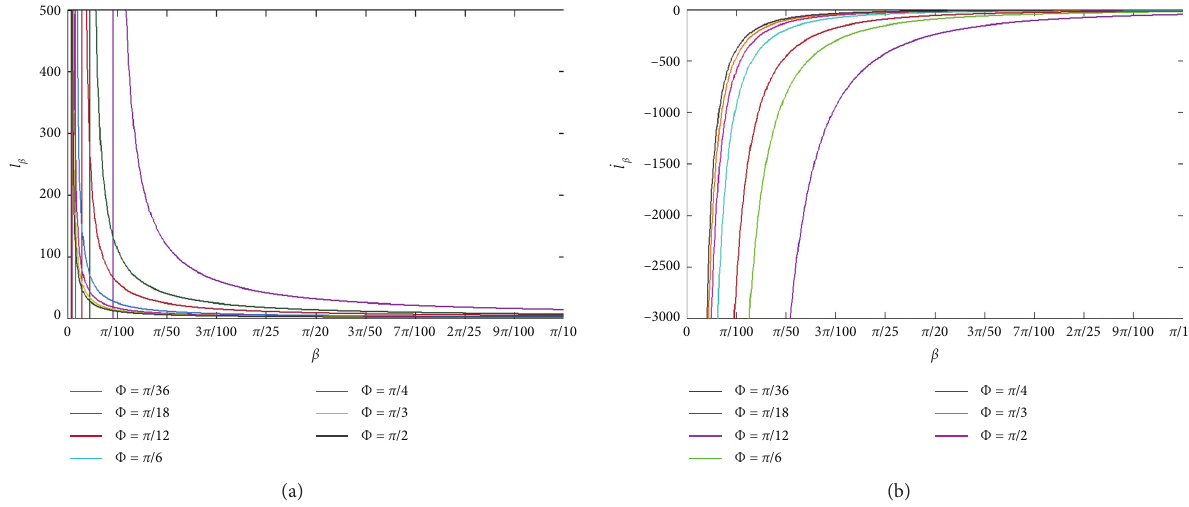
Figure 5: The relationship between the length of the gravity block l and the length change rate _ l different stability angles ϕ